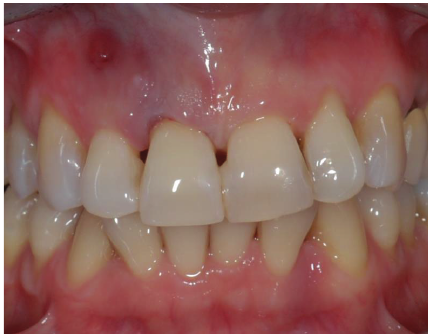
Figure 1: Front side view of patient upon presentation.